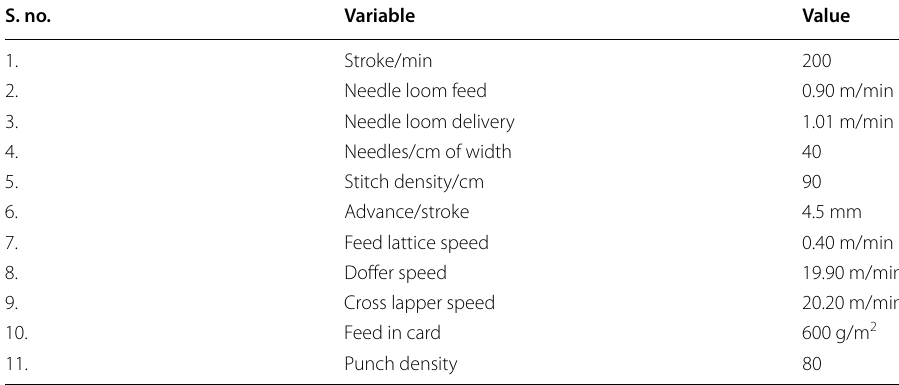
Table 2 Process parameter for non-woven needle punching S.